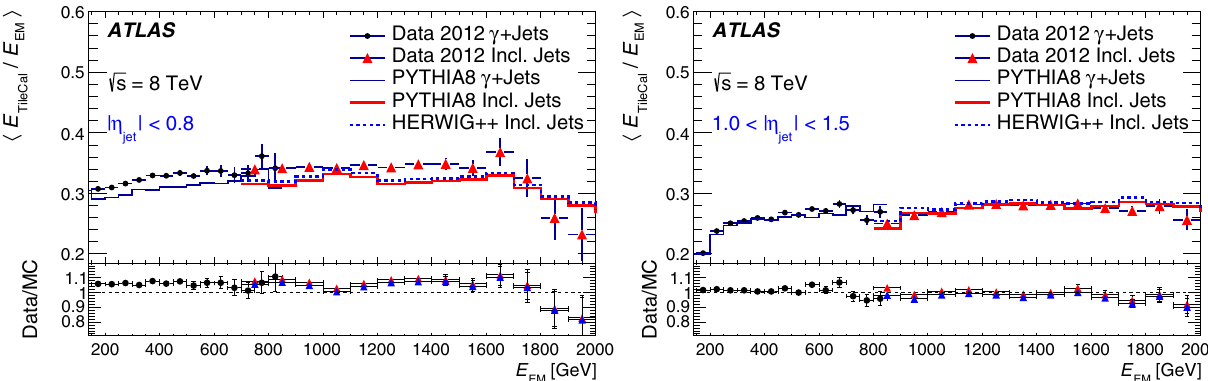
Pythia 8 (thick solid line) and Herwig++ [54] (dotted line) MC gen- erators can be seen, while γ + jets events were simulated only with Pythia 8 (thin solid